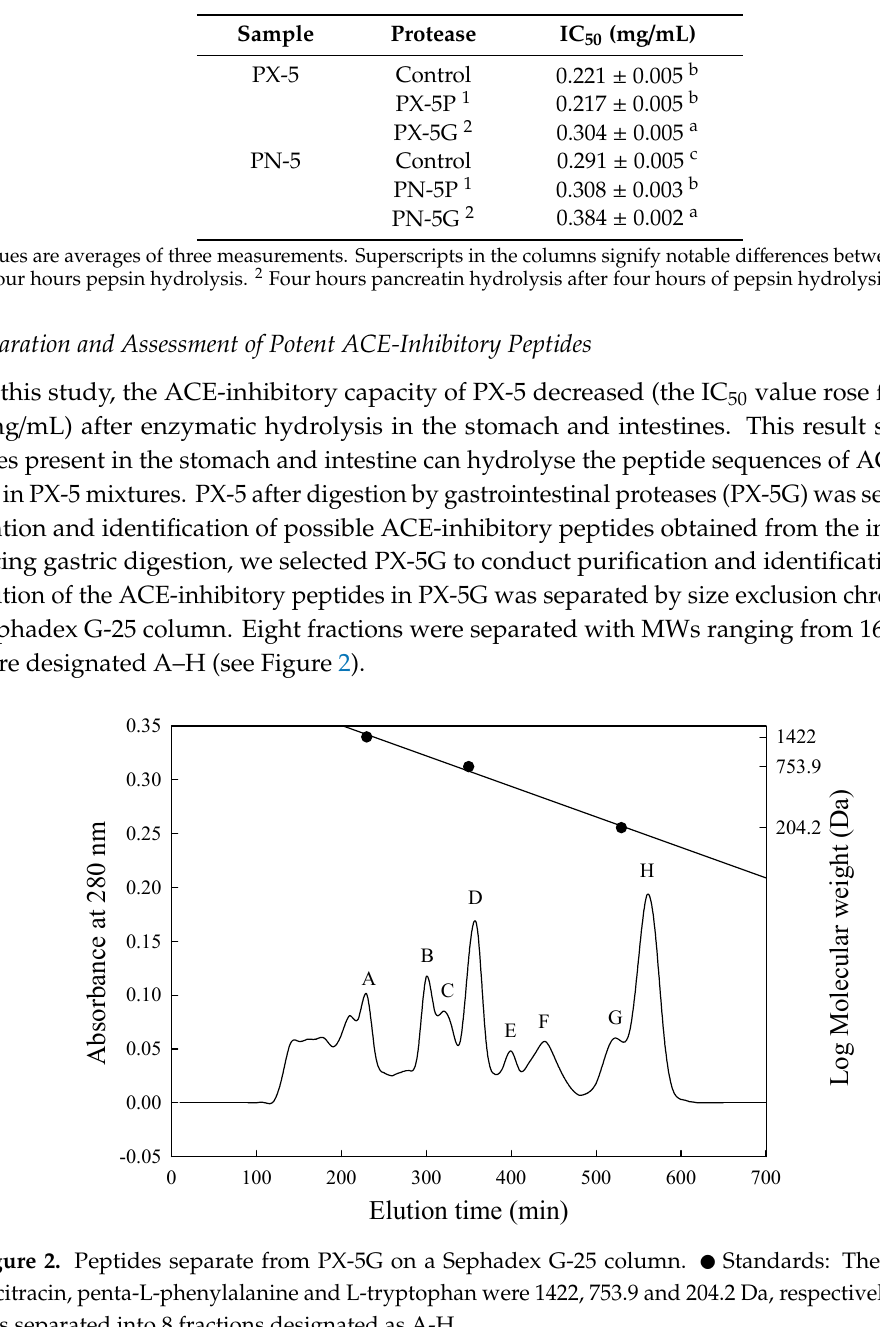
Table 3. ACE IC 50 values of fractions obtained by size exclusion chromatography from PX-5 after gastrointestinal digestion.